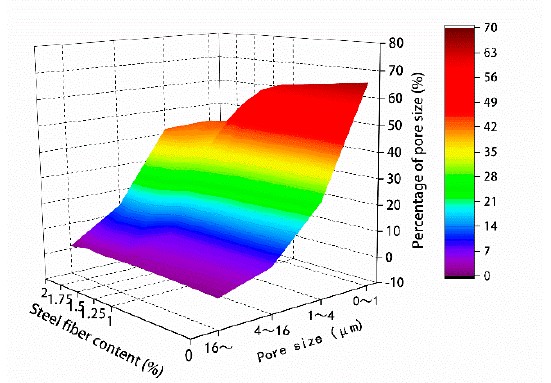
Figure 20. Percentage of pore size.